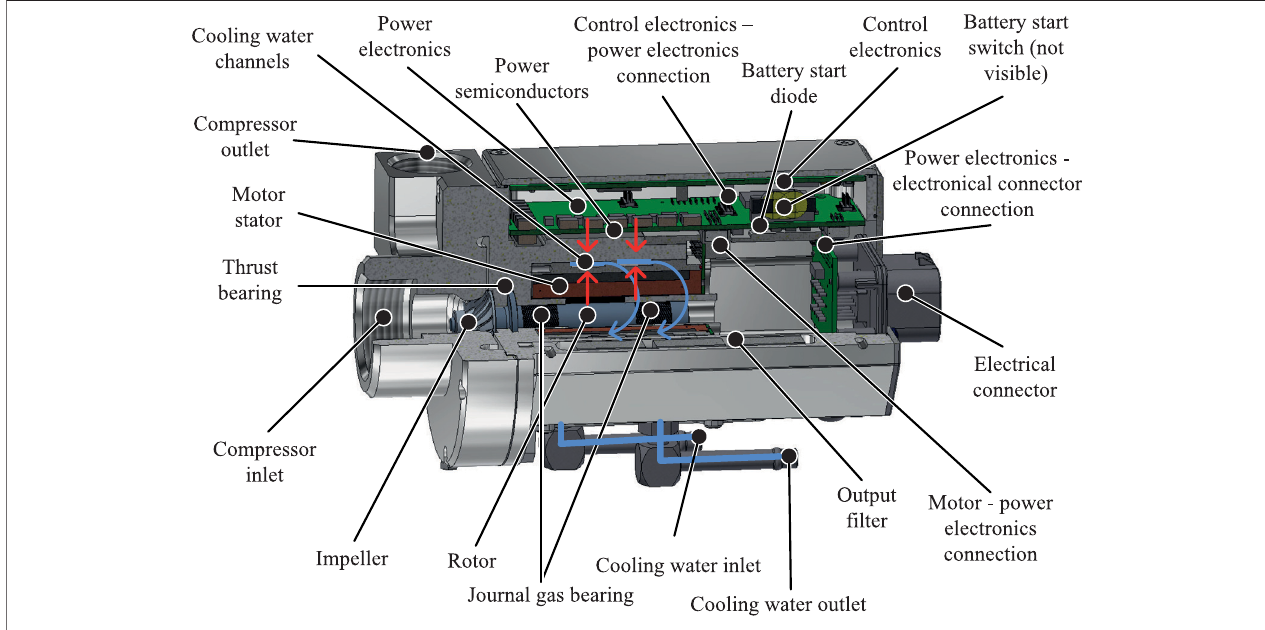
FIGURE 8 | CAD drawing of a novel high-speed turbo compressor system with an integrated inverter. Temperature sensors for the experimental veri fi cation are installedinthemotorstator,attheoutput fi lter,batterystartswitch,batterystartdiode,andinverterpowersemiconductorsinordertoverifythecoolingconcept.Thered arrows represent the heat fl ow from the inverter and the motor to the coolant. The blue arrows indicate the coolant fl ow.